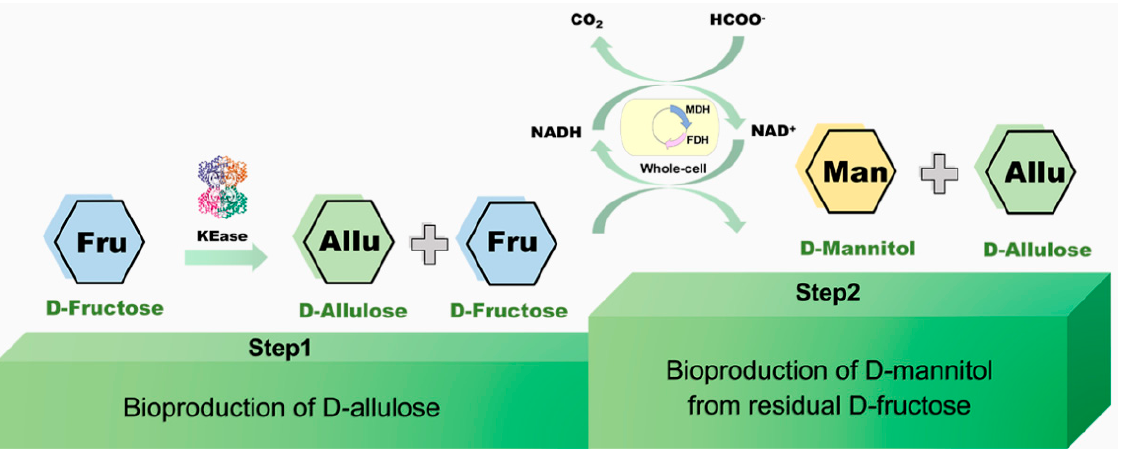
Figure 1. Schematic representation of bioproduction of D-allulose and D-mannitol from D-fructose via multi-enzyme and whole-cell catalysis system developed in this study.